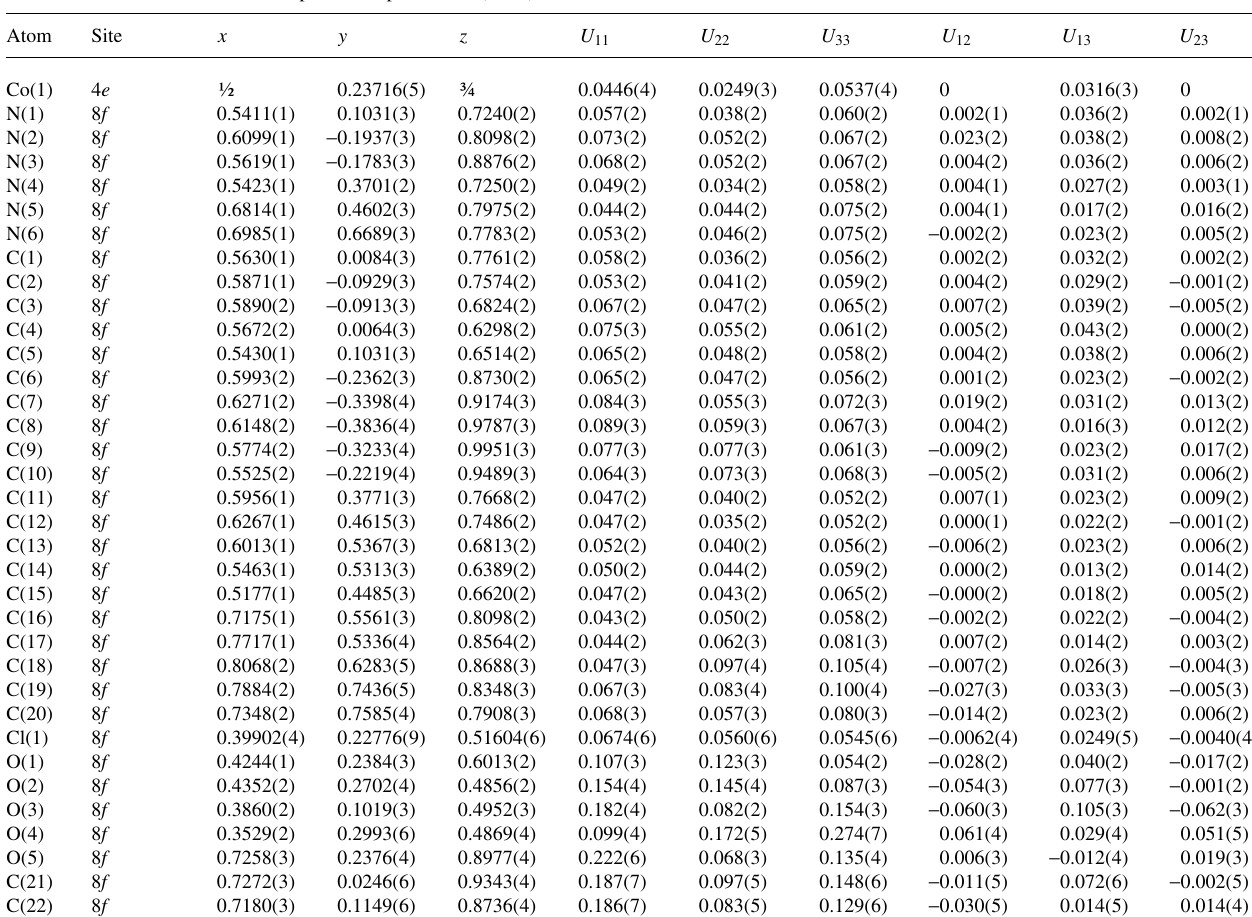
Table 3. Atomic coordinates and displacement parameters (in Å 2 ) .